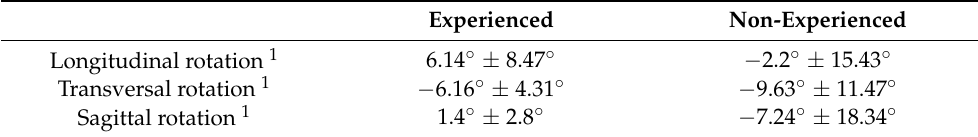
Table 4. Difference in angular orientation between the initial and retracted defensive position jab